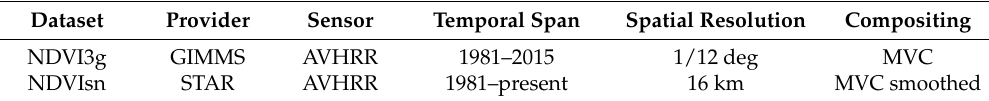
Table 1. Description of GIMMS and STAR NDVI datasets used in the study.